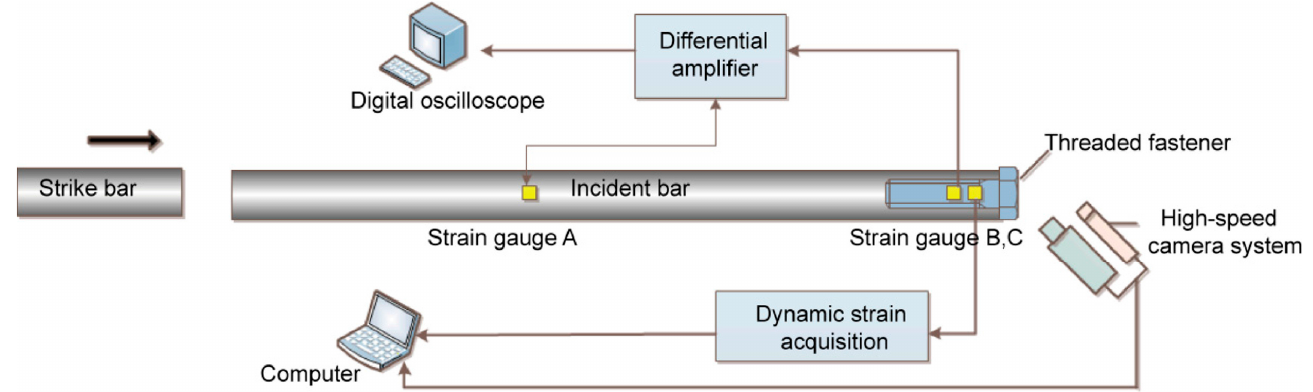
Figure 21. Apparatus used in the study of impact loading on threaded connections [192].